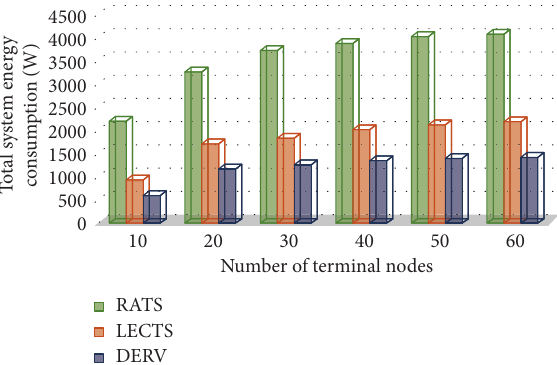
Figure 6: The overall energy consumption of three different schemes.